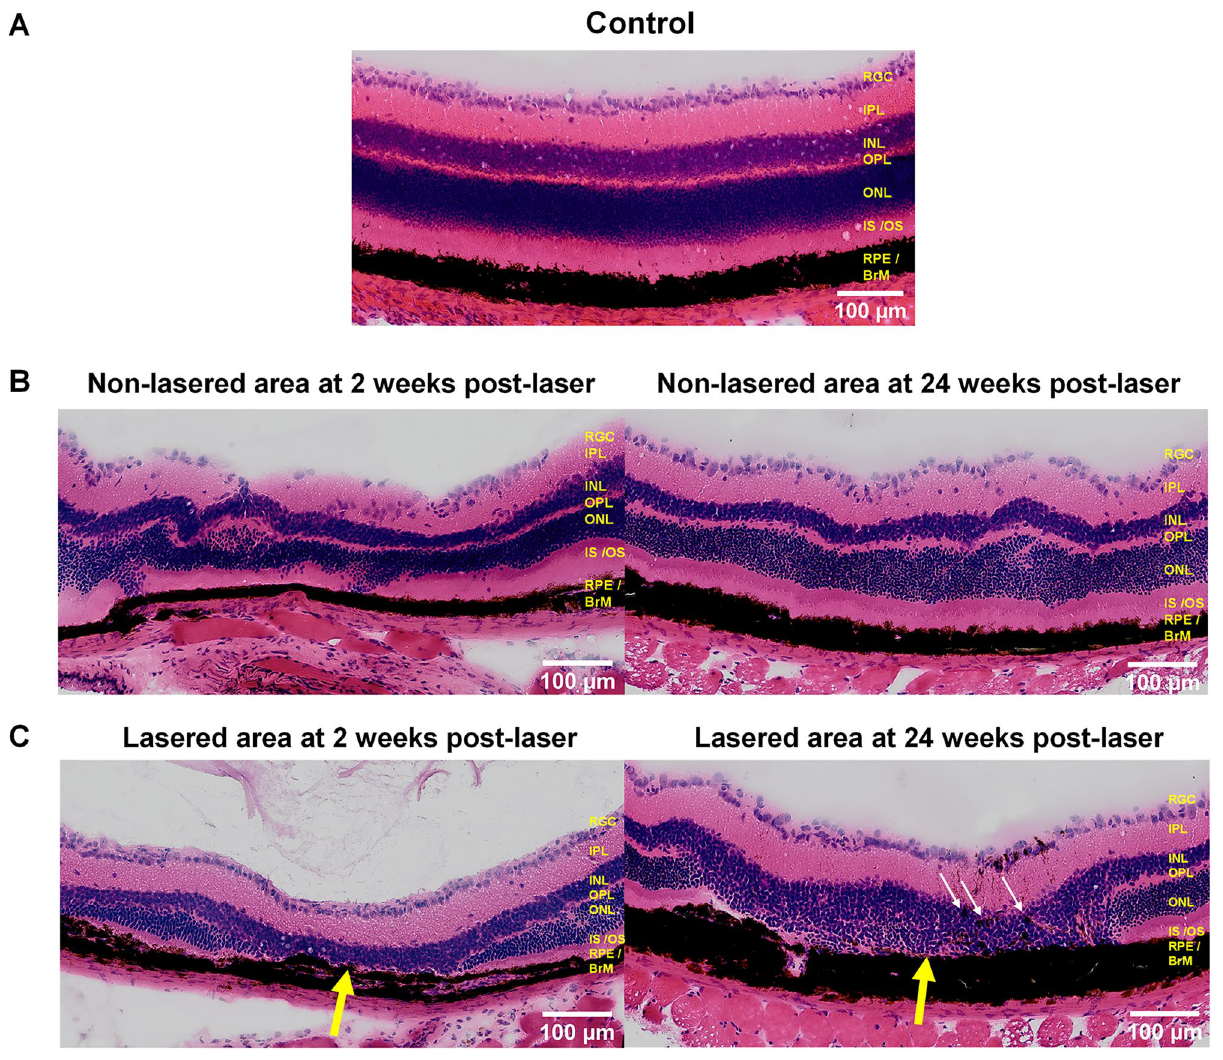
Figure 3. Histological changes observed in RLCS are typical of GA pathology. Representative Haematoxylin and Eosin (H&E) stained retinal sections from ( A ) naïve control mice; ( B ) non-lasered areas of retina and ( C ) corresponding laser spot areas at 2 weeks (left) and 24 weeks (right) after laser treatment to induce a RLCS. Sections taken from lasered eyes demonstrate loss of the IS/OS junction, with apparent migration of RPE into the INL (white arrows), intact BM and choroid and collapse of the INL and ONL into the lesion site (yellow arrows). Retinal ganglion cell layer (RGC); inner plexiform layer (IPL), inner nuclear layer (INL), outer plexiform layer (OPL), outer nuclear layer (ONL), photoreceptor inner segment / outer segment junction (IS/ OS), retinal pigment epithelium—Bruch’s membrane interface